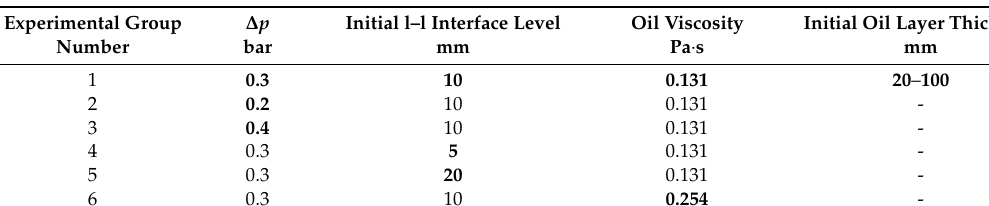
Table 2. Experimental conditions. Changed parameters are written in bold. The dynamic viscosity of water is 0.001 Pa·s for all the experiments.